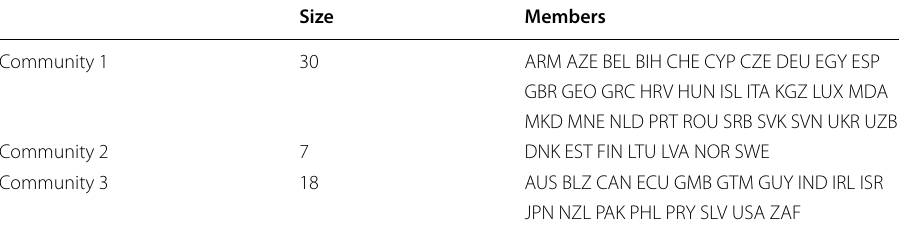
Table 13 Members of the communities detected by applying the Louvain method in 2020